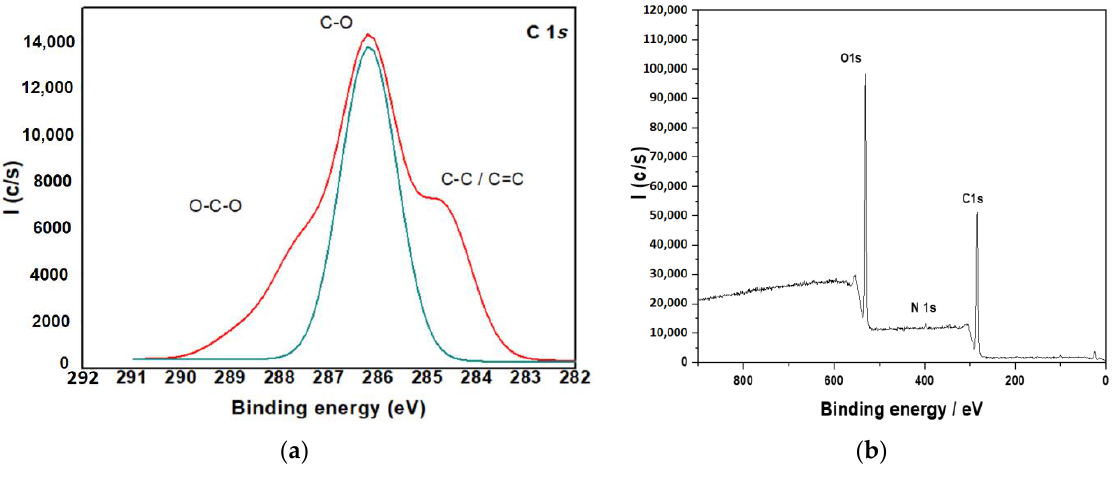
Figure 6. XPS for ( a ) C 1s; ( b ) O 1s core level of CTs.